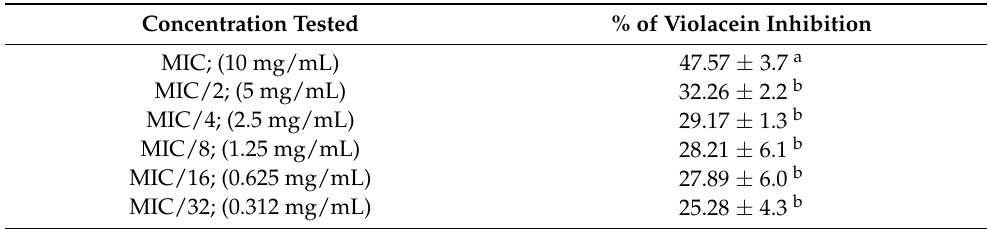
Table 5. Inhibition of violacein production by C. violaceum ATCC 12472 by caraway essential oil at different MIC values. The letters (a,b) indicate significant difference according to the Duncan test ( p < 0.05).